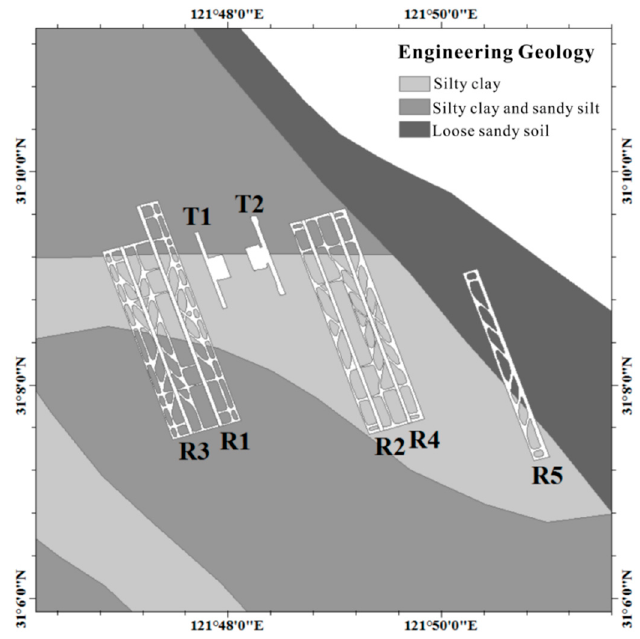
Figure 7. The engineering geology condition of the Pudong International Airport area.